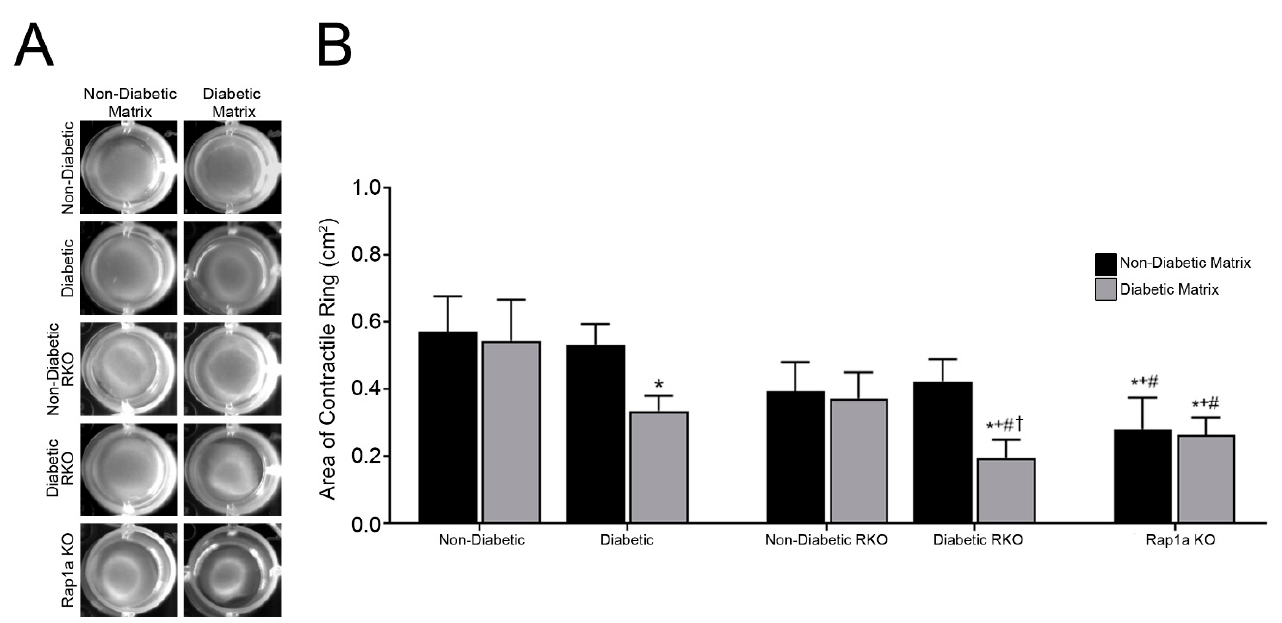
Figure 1. The presence of RAGE, Rap1a, and isolated ECM altered the area of contractile ring in cardiac fibroblasts. Cardiac fibroblasts were isolated from non-diabetic, diabetic, non-diabetic RKO, diabetic RKO, and Rap1a KO hearts and embedded in either non-diabetic or diabetic collagen matrix for 7 days. ( A ) Representative images of cardiac fibroblasts embedded in non-diabetic and diabetic collagen. ( B ) Depiction of the area (mean ± SEM) of the contractile ring with n = 5–10. Significance was determined by a two-way ANOVA followed by a Fisher’s Least Significant Difference post hoc. Symbols above bars indicate significance between two designated groups ( p < 0.05; * vs. non-diabetic fibroblasts in non-diabetic matrix, + vs. non-diabetic fibroblast in diabetic matrix, # vs. diabetic fibroblasts in non-diabetic matrix, and † vs. diabetic RKO fibroblasts in non-diabetic matrix). Black bars represent cardiac fibroblasts embedded in non-diabetic collagen and gray bars indicate cells embedded in diabetic collagen.